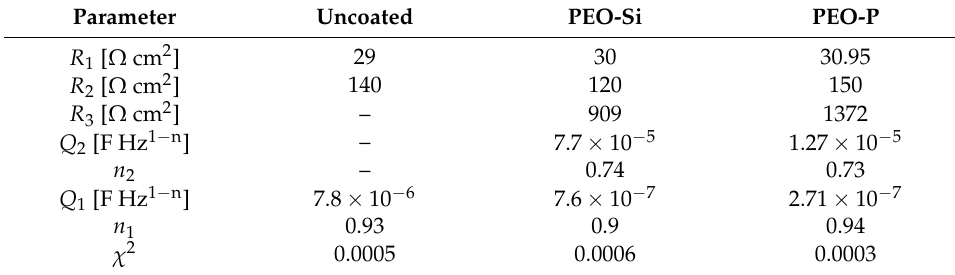
Figure 6. Nyquist plots of the PEO-Si and PEO-P samples (test electrolyte: 0.1 M Na 2 SO 4 and 0.05 M NaCl). Table 4. Results of the fitting of the experimental data obtained from EIS tests.